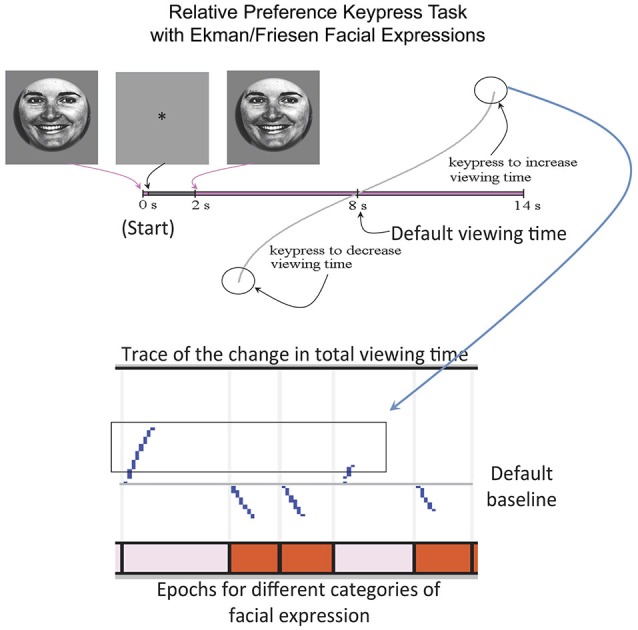
Keypress Paradigm. The behavioral task done outside the MRI to minimize motor confounds to activation is schematized above, with an example raster plot below.